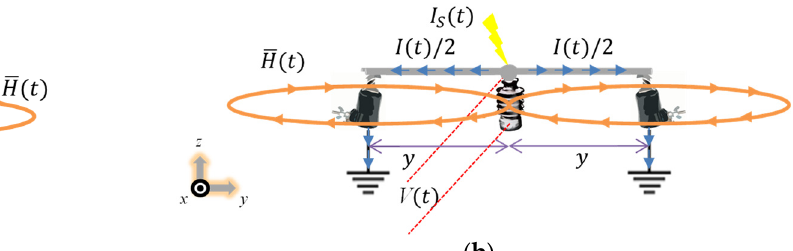
Figure 7. Illustrative representations of insulator and arrester(s) connected to voltage line and respective SA-produced magnetic fields: ( a ) typical case and ( b ) the proposed arrangement based on two parallel SAs.